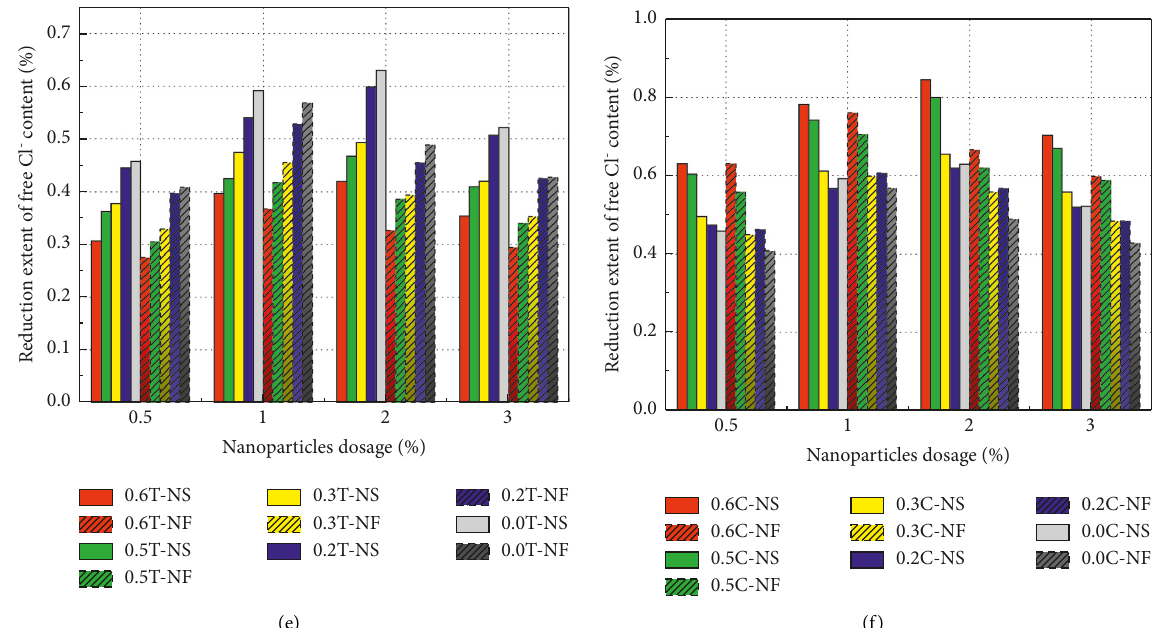
Figure 12: (a) Tensile zone (4d). (b) Compressive zone (4d). (c) Tensile zone (21d). (d) Compressive zone (21d). (e) Tensile zone (30 d). (f) Compressive zone (30d).